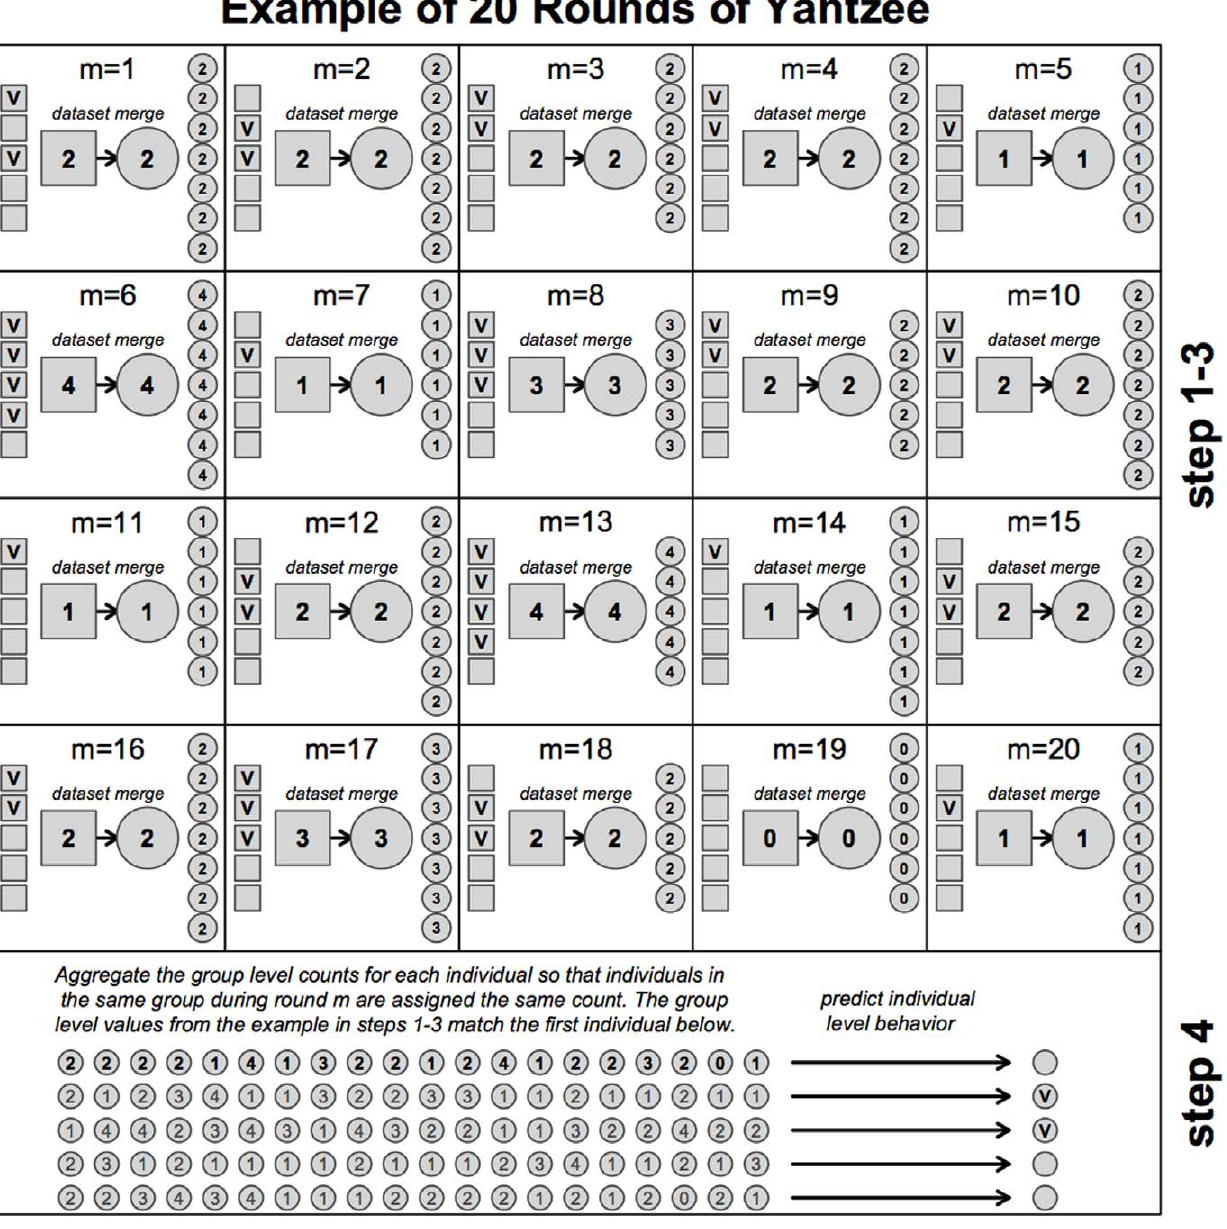
Figure 1. Step 1 of the Yahtzee procedure begins with the hashing of the datasets using a new salt (See Table 1 above). In step 2 the group ID is determined for all groups where g ~ 5 in the origin dataset and then matched to the same group ID from the destination group-level dataset. Notice that the hashing procedure and group aggregation is the same in both datsets except we keep all groups in the destination dataset, regardless of size. This is so because we only need to know the group size from the origin dataset to make predictions about the behavior in the destination dataset. Once the group-level datasets are matched by the group ID, the group-level information is stored and the process is repeated m times. In step 3 the group level data is sent to the holder of the destination dataset so that the group level values can be assigned to the individual observations based on the same hashes used in the construction of the groups during each of the Yahtzee rounds. Once the destination dataset has acquired a sufficient number of group level values (see Figure 2 for information on determining the value of m ) it is possible to then use the combined information to predict the behavior of each individual, which is step 4 of the Yahtzee procedure. For our application, using equations 4, 5 and 6 above, it is possible to predict if the individual is unregistered, a voter or an abstainer. Finally, it is worth repeating that only the group-level data is passed from the origin to the destination dataset. See the Pseudocode for additional information. doi:10.1371/journal.pone.0055760.g001 Using the state voting data, we calculated the number of the voter record), this procedure prevented identification of a specific Facebook user’s behavior. The proportion of truly registered voters in each group who did vote (some number matched Facebook users in any group was unknown and could between 0 and g ) in 2010. We recorded that number and assigned range from 0% to 100%. it to each Facebook user with the same group ID. Importantly, a